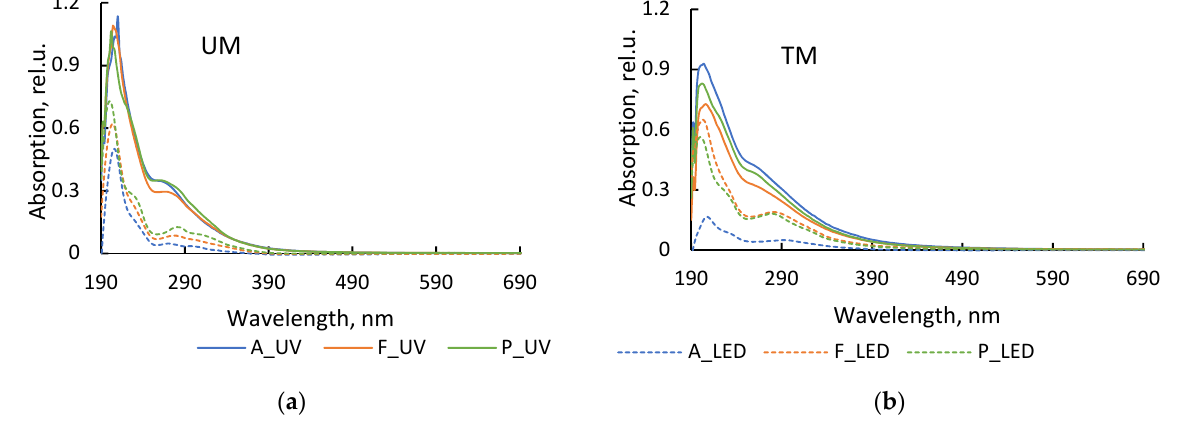
Figure 5. UV-Vis absorption spectra of water extracts of unmodified (UM) ( a ) and thermally modified (TM) ( b ) aspen (A), ash (F), and pine (P) wood exposed to UV and LED lamps.